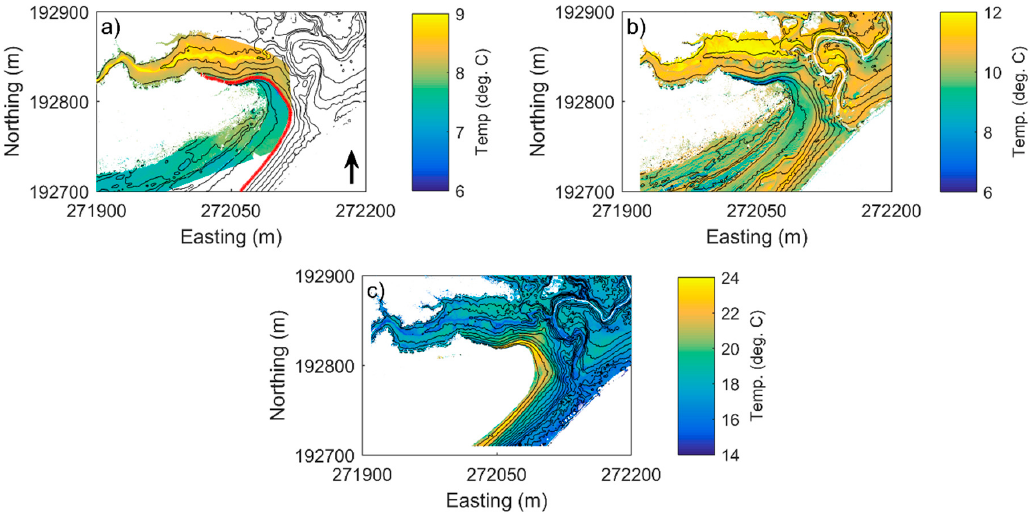
Figure 5. A plot of UAS measured temperature against point measured temperature, with the line of best fit indicated ( a ); point-measured moisture content against point measured temperature ( b ); and point-measured moisture content against point-measured elevation ( c ). Data is from the three flights at the Neath site with color indicating flight data and shape of symbol indicating sediment type as shown on the legend.